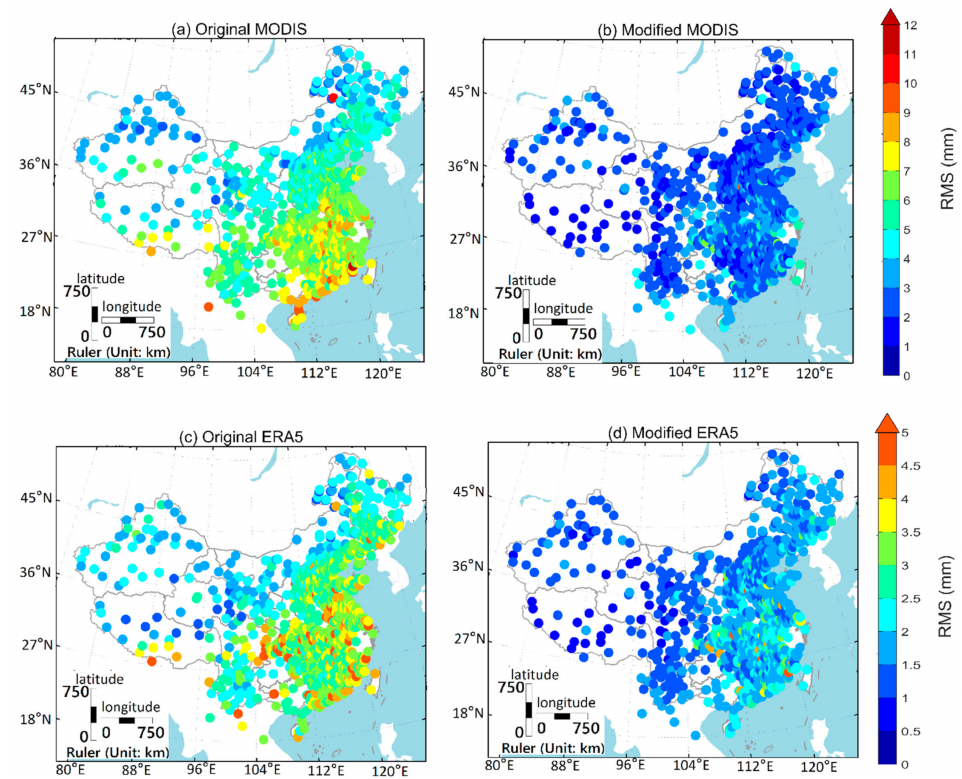
Figure 11. PWV RMS at individual stations of the original MODIS (ERA5) PWV and the modified MODIS (ERA5)